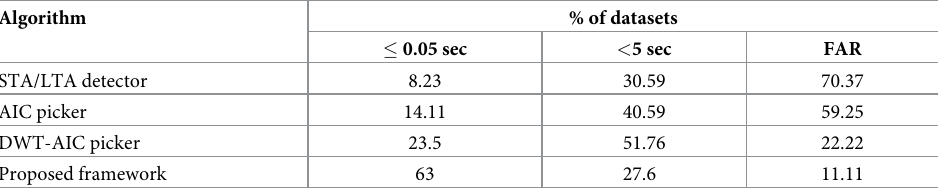
Table 5. Detection/Picking rate and false alarm rate in percentage. FAR stands for false alarm rate which is defined as the % of datasets with false detection of event.